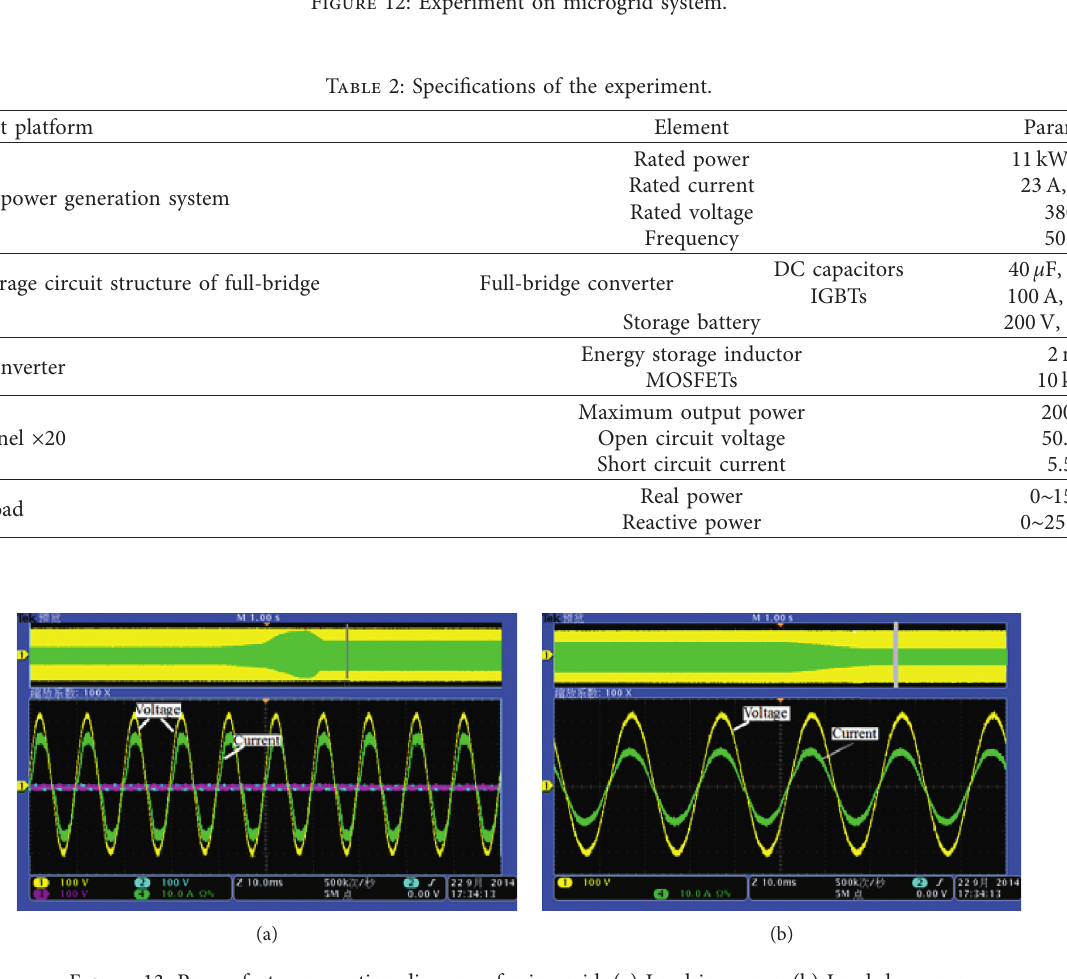
Figure 13: Power factor correction diagram of microgrid. (a) Load increases. (b) Load